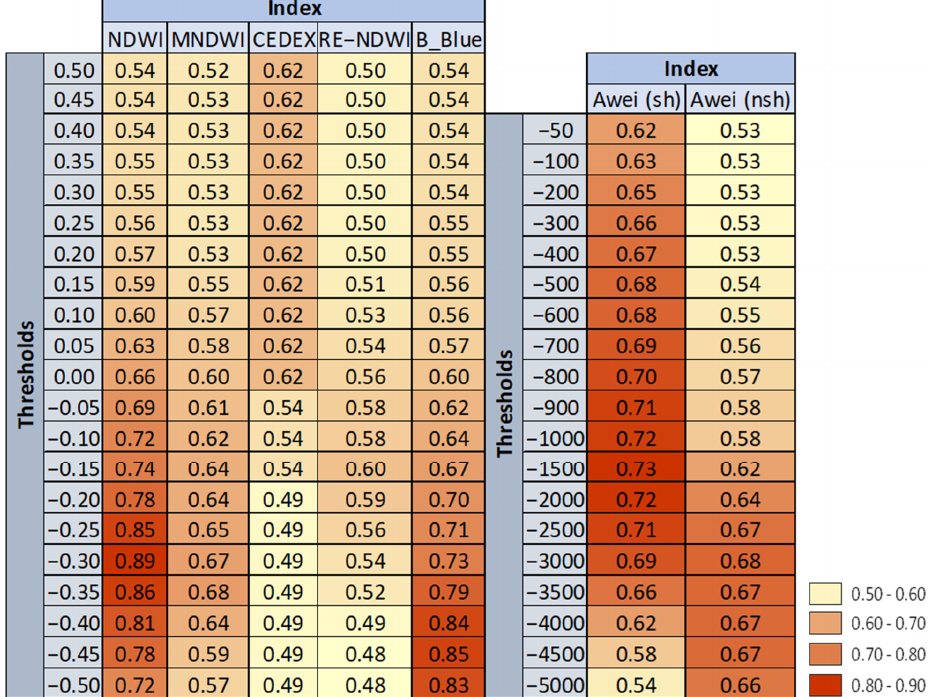
Figure 3. Overall accuracy of tested indices at different thresholds.